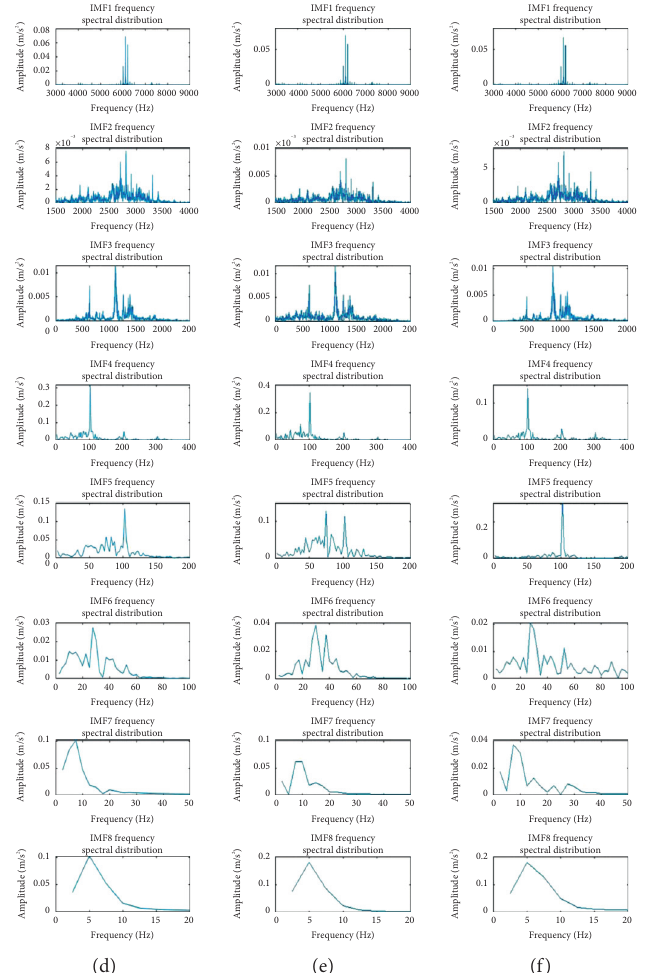
Figure 12: Hilbert marginal spectrum of IMFs by different methods. (a) EMD. (b) EEMD with WGN in 0 dBW. (c) EEMD with WGN in − 10dBW. (d) EEMD with WGN in − 30dBW. (e) EEMD with WGN in − 50dBW. (f) NSEEMD proposed in this study.